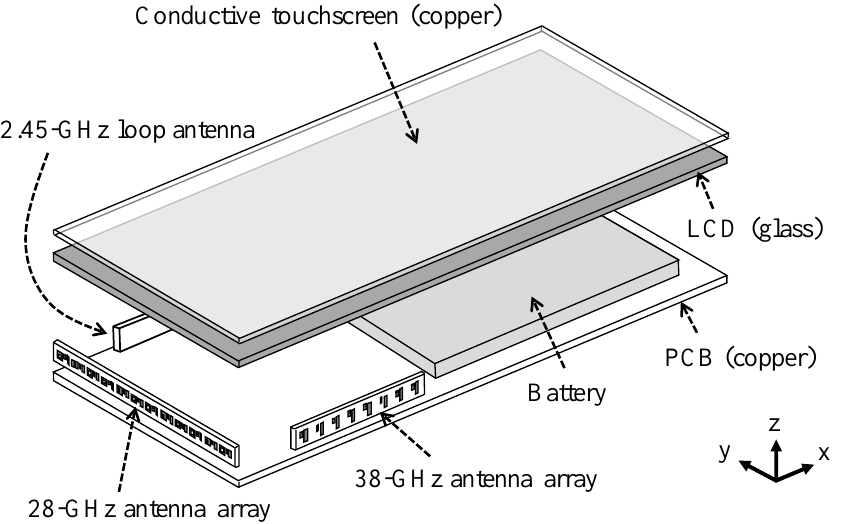
Figure 1. Design environment for the three antenna modules.